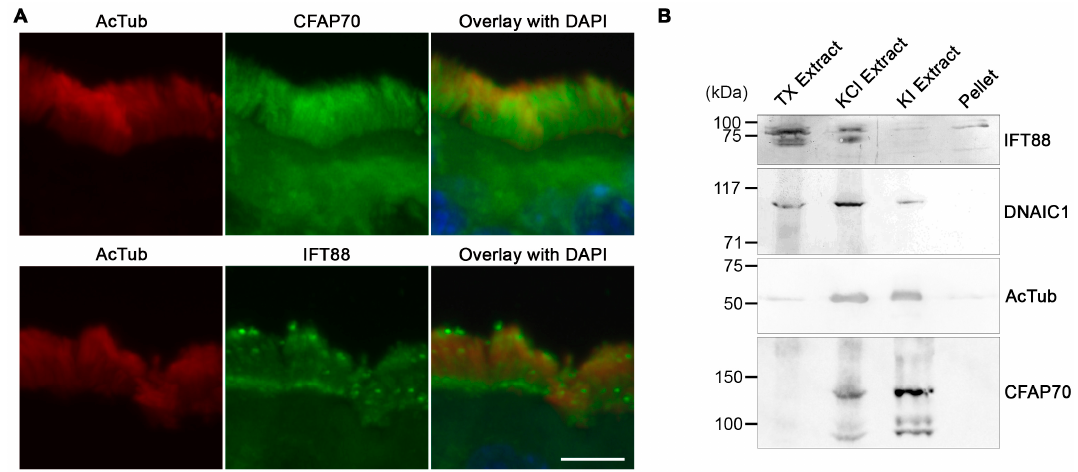
Figure 2. Comparison of the intra-ciliary distribution between CFAP70 and IFT88. ( A ) Confocal microscopy of mouse tracheal tissue immunostained for CFAP70 (top panels) and IFT88 (bottom panels). Bar, 5 µ m. ( B ) Isolated swine tracheal cilia were extracted sequentially with 0.1% Triton X-100, 0.6 M KCl, and 0.6 M KI. The resulting supernatants (TX, KCl, and KI, respectively) and final pellet were analyzed by Western blot using antibodies against the indicated ciliary proteins. To the left of the gel, the positions and sizes (kDa) of molecular weight standards are indicated.